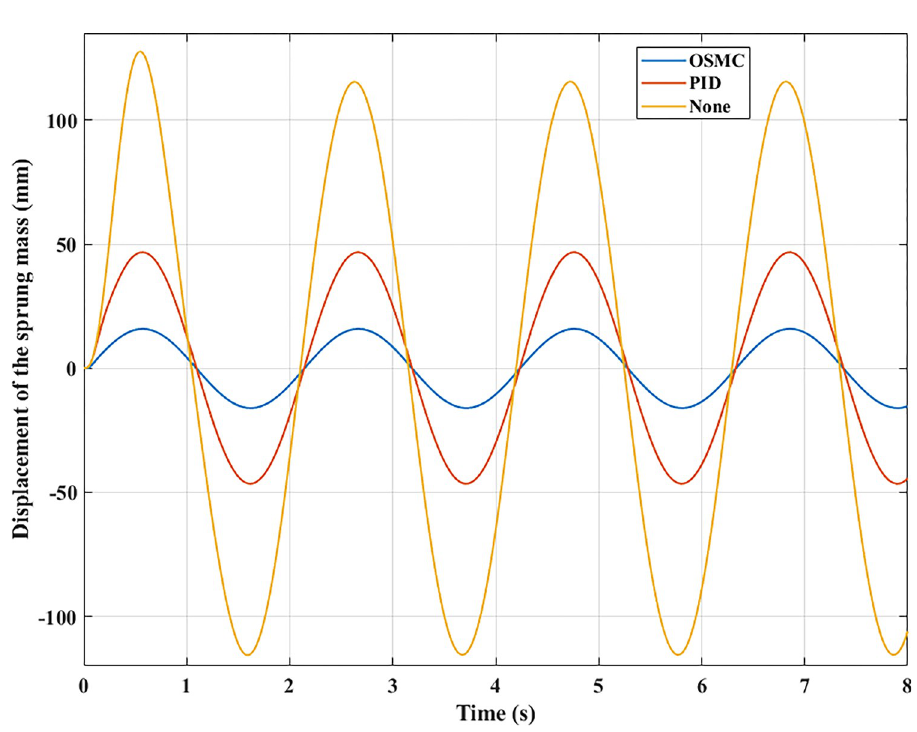
Fig 6. Displacement of the sprung mass (case